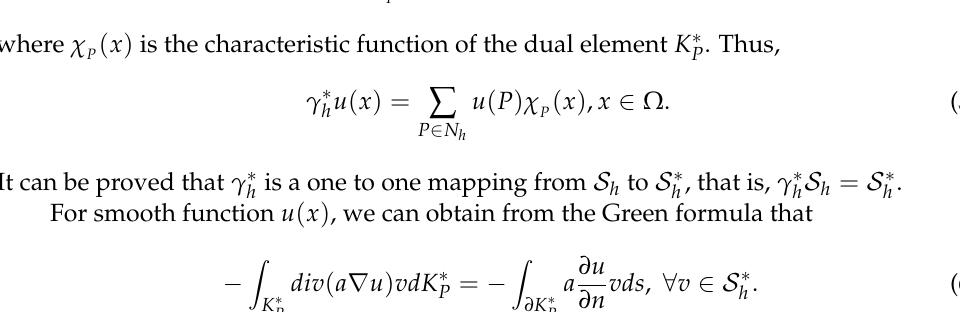
Figure 1. Dual element K